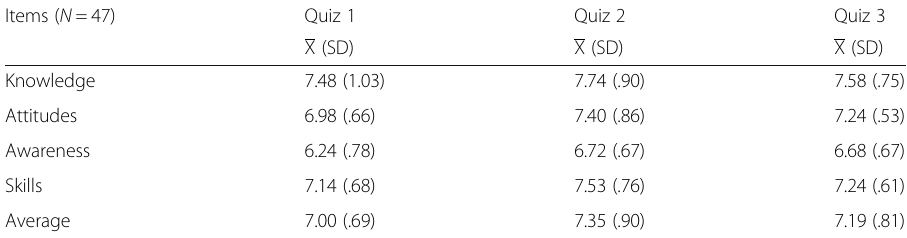
Table 7 EFL learners ’ IC - Formative test